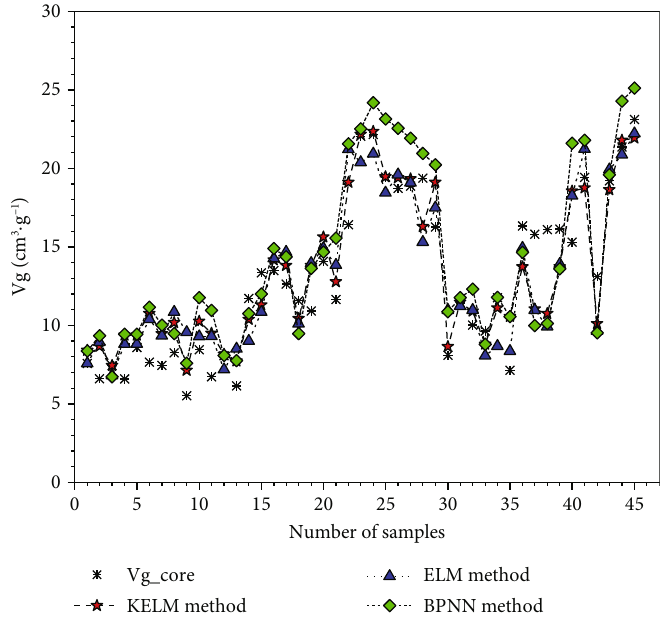
Figure 18: Performance of three methods on the same testing